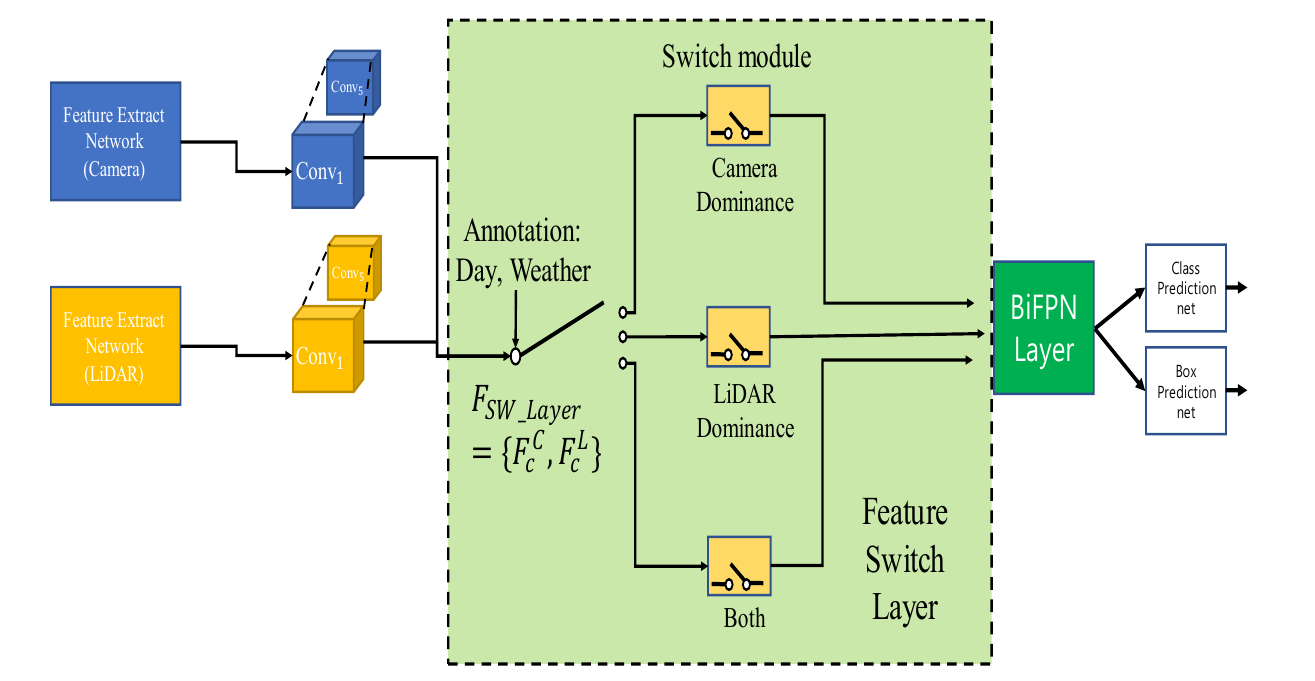
Figure 2. Structure of the feature switch layer when five convolution block features are declared. In the feature switch layer, each sensor and both sensors are declared to have different influences for each sensor.